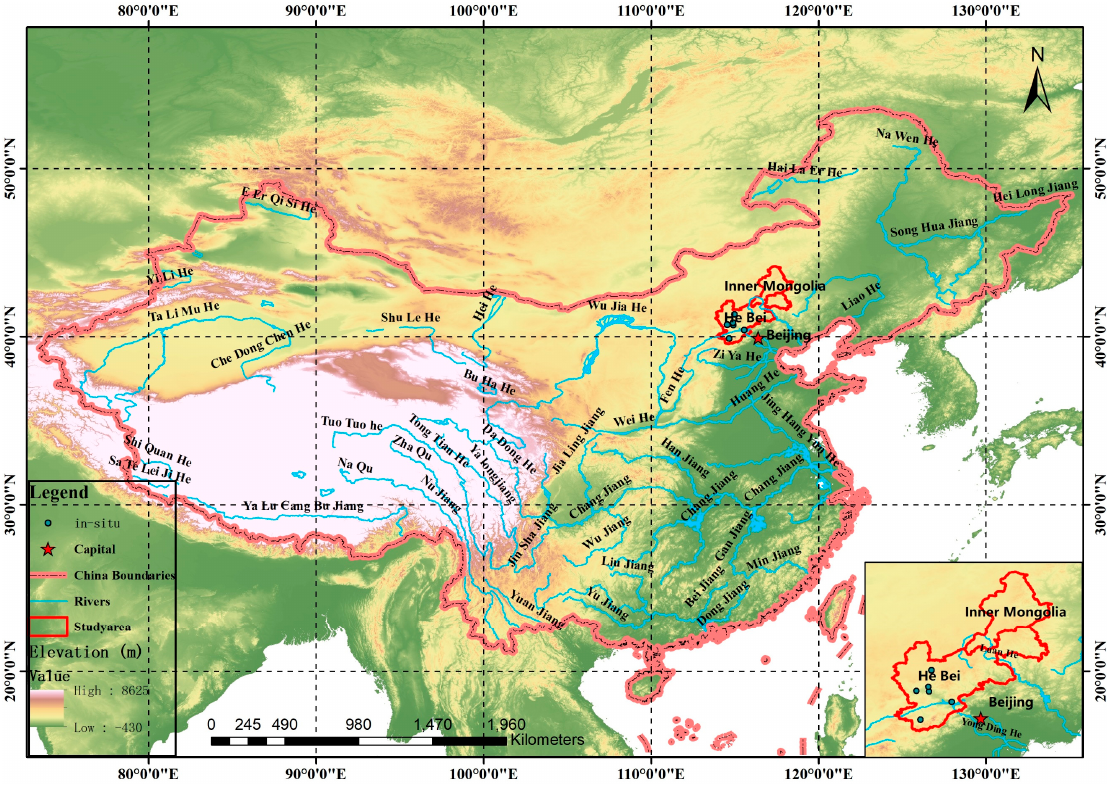
Figure 1. Spatial location and elevation map of the study area.